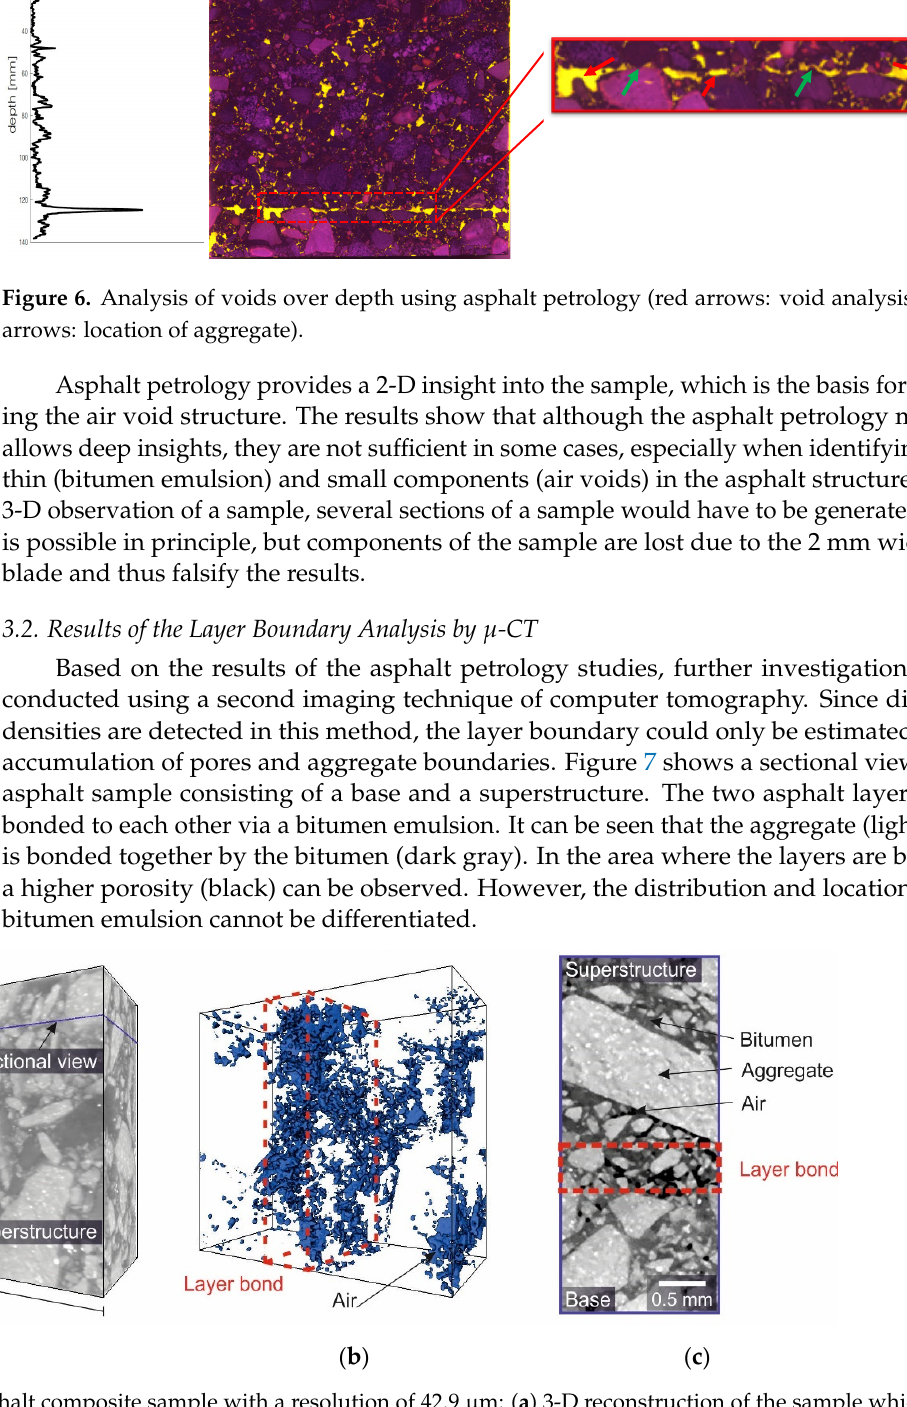
Figure 7. CT-Scan of an asphalt composite sample with a resolution of 42.9 µm: ( a ) 3-D reconstruction of the sample which provides an overview of the measurement; ( b ) model of the entrapped air; ( c ) sectional view into the sample.